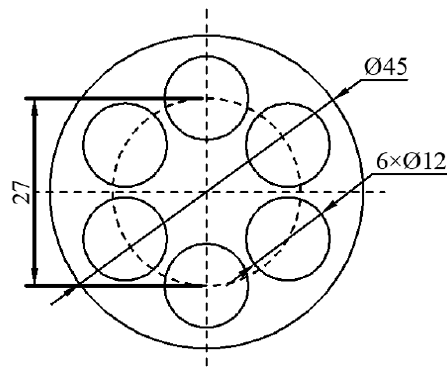
Figure 1. Sampling location of hot compressed specimens.